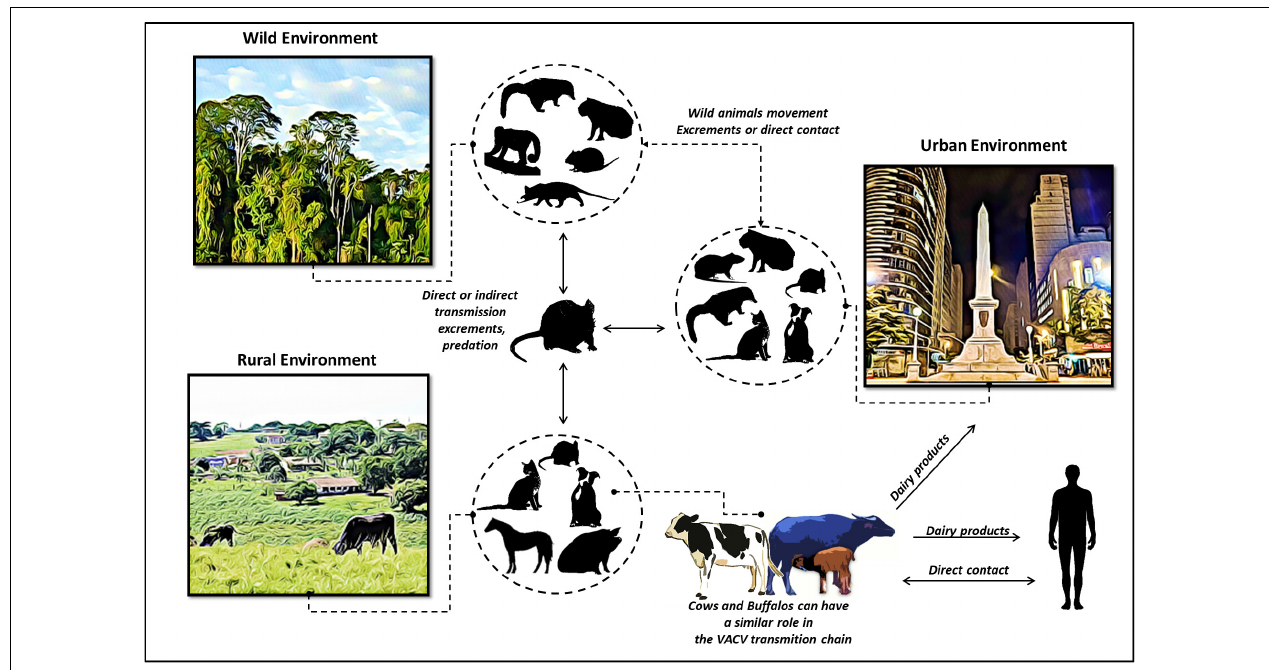
FIGURE 5 | Update of the dynamics of vaccinia virus circulation, represented by a hypothetical model. Wild, rural, and urban environments are shown, and viral association among the different hosts is highlighted. In this updated model, rural VACV outbreaks affecting buffaloes, humans, and dairy cattle are shown. In the VACV transmission cycle, peridomestic rodents can transmit VACV directly or indirectly among buffaloes, humans, and other farm animals, thereby forming links between these environments. Peridomestic rodents and other wild species (capybaras and coatis) could also spread VACV, thus facilitating the connections among urban, wild, and rural areas. In addition, other domestic animals represented in the figure could be implicated in the VACV transmission chain. Another suggested route is that of VACV spread from bovine and bubaline animals to humans through dairy